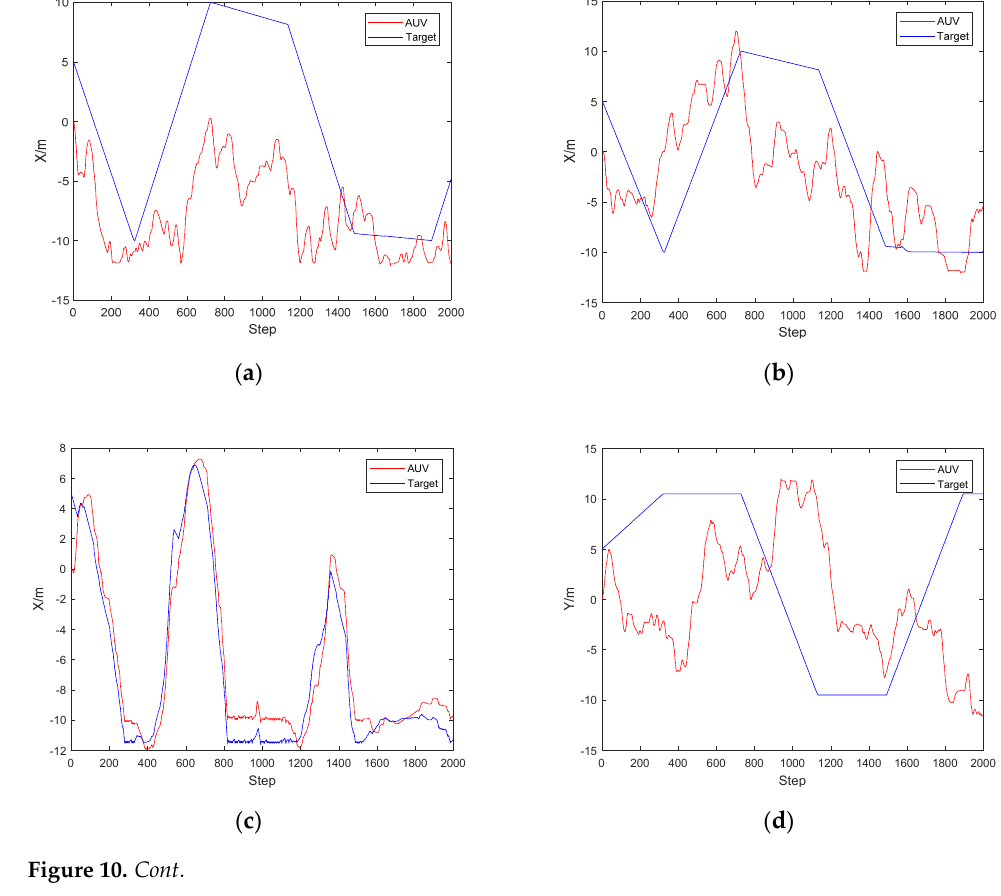
Table 4. Comparison of tracking performance after AUV training 20,000 times using PPO, GAIL, and MAG in Scenes 1 and 2.